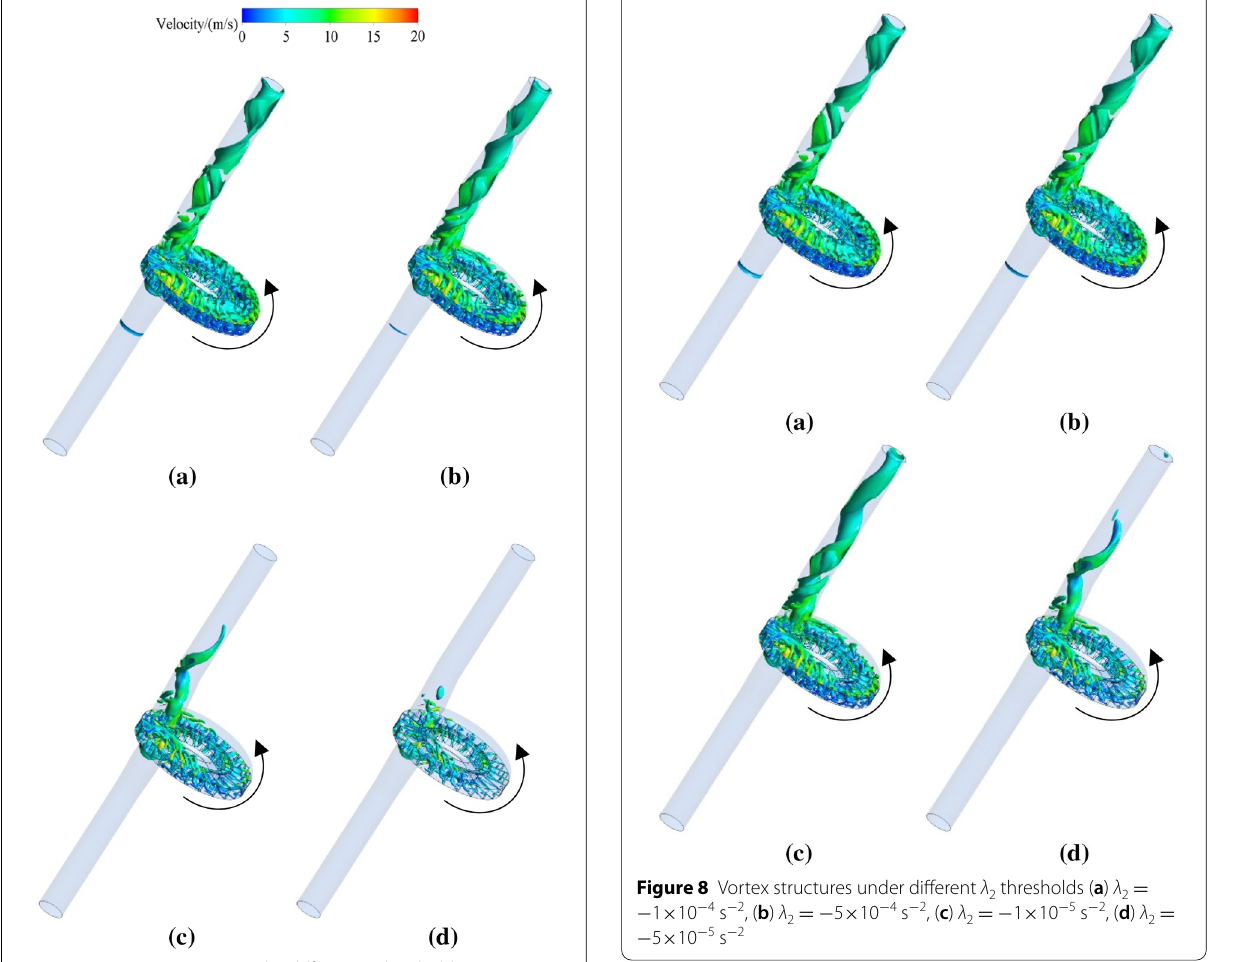
Figure 7 Vortex structures under different Q thresholds ( a ) Q 1